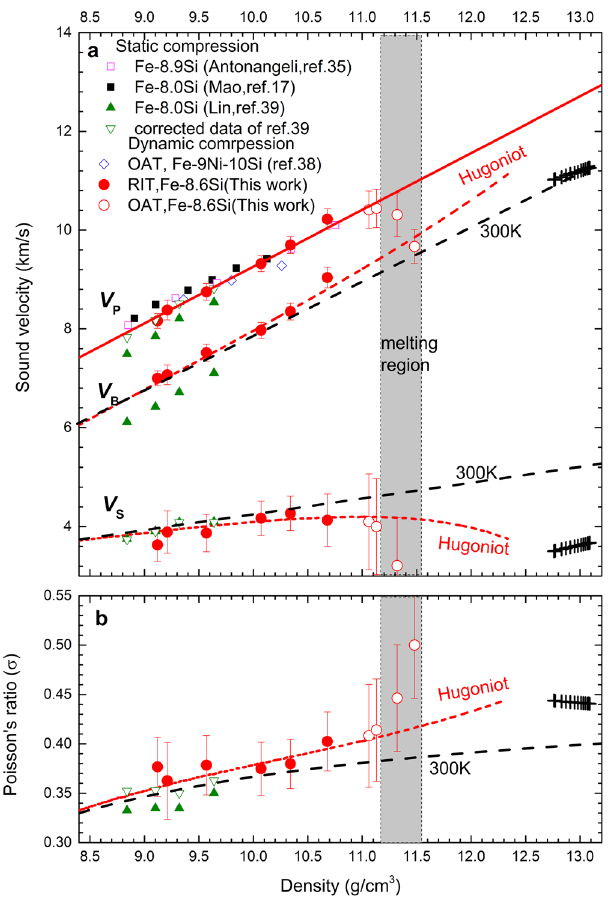
Fig. 4 Sound velocities and Poisson ’ s ratio of Fe-8.6Si alloy as a function of density. a The measured V P along Hugoniot by the RIT (red solid circles) and the OAT (red open circles) are compared with shockwave data for Fe- 9Ni-10Si 38 . The solid red line represents the linear fi t to the V P measurements for solid Fe-8.6Si alloy. The static V P data of Fe-8Si by NRIXS 39 and of Fe – 8.9Si 35 , Fe-8Si 17 by IXS are also plotted for comparison. The measures V B along Hugoniot by the RIT and the derived V S from this study are shown by red circles, compared with NRIXS data at 300 K 39 . The olive open inverted triangles are the corrected values based on the equation of state for Fe-8.6 Si 40 and the measured V D by NRIXS 39 . The black dashed line for V B is calculated from the equation of state at 300 K, and the red dashed V B -line is the calculated V B from Hugoniot equation of state. The black and red dashed lines for V S represent the calculated results from V P and V B , at 300 K and along Hugoniot, respectively. b The derived Poisson ’ s ratios σ from this study are compared with the room-temperature NRIXS data. All measurements are compared with the observed values (black crosses) from PREM 14 . The boundaries of the melting region (shaded area) were determined according to the discontinuities of the sound